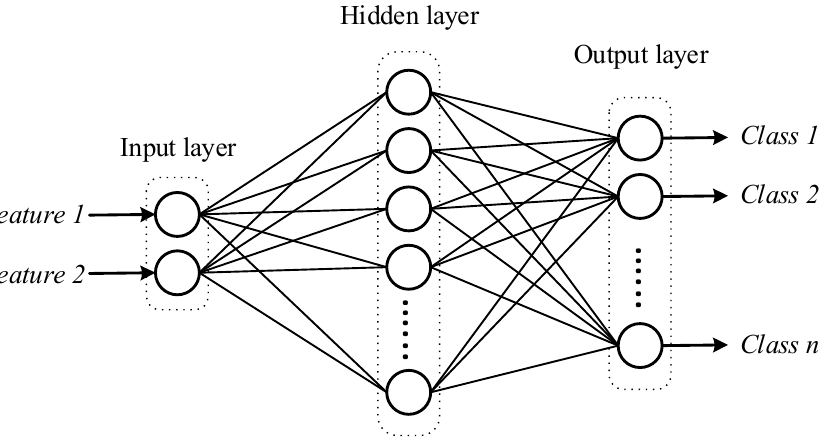
Figure 3. The multi-layer structure of the proposed NN-based classifier for assessing the different bearing conditions under study.